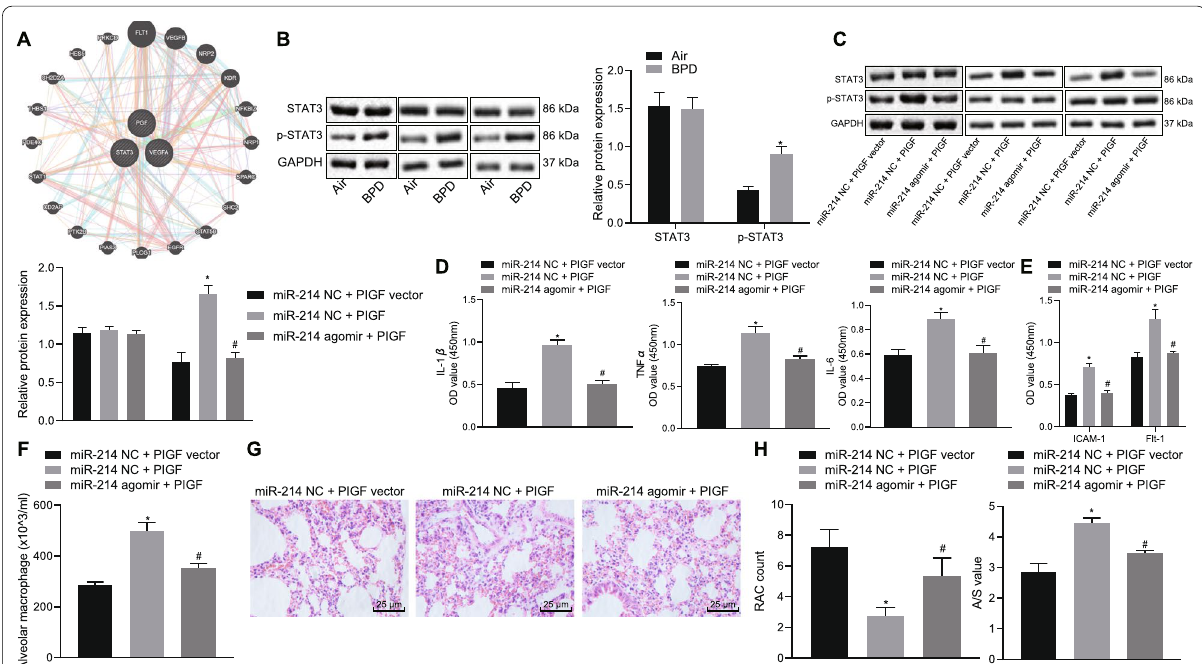
Fig. 6 miR‑214 overexpression blocks the effect of the activated STAT3 pathway on alveolarization by inhibiting PlGF in neonatal rats with BPD. A The KEGG and GeneMANIA databases were used to predict the regulatory pathways downstream of PlGF. B Western blot analysis of the activation of the STAT3 pathway in BPD neonatal rats normalized to GAPDH. Neonatal rats with BPD were then treated with miR‑214 NC miR‑214 NC PlGF, or miR‑214 agomir PlGF. C Western blot analysis of the expression of STAT3 and phosphorylated STAT3 in lung tissues of BPD + + neonatal rats, normalized to GAPDH. D Quantification of the levels of the inflammatory factors IL‑1β, TNF‑ ɑ , and IL‑6 by ELISA. E Quantification of the levels of ICAM‑1 and Flt‑1 by ELISA. F Giemsa staining of the number of macrophages. G H&E staining of the formation of pulmonary alveoli ( H H&E staining of the number of alveoli and alveolar growth. Measurement data are summarized as the mean BPD rats treated with miR‑214 NC PlGF vector. # p < 0.05 vs. BPD rats treated with miR‑214 NC + comparisons between two groups. Comparisons between multiple groups were performed using one‑way ANOVA, followed by Tukey’s post hoc test for multiple comparisons. n 3 for rats in each =